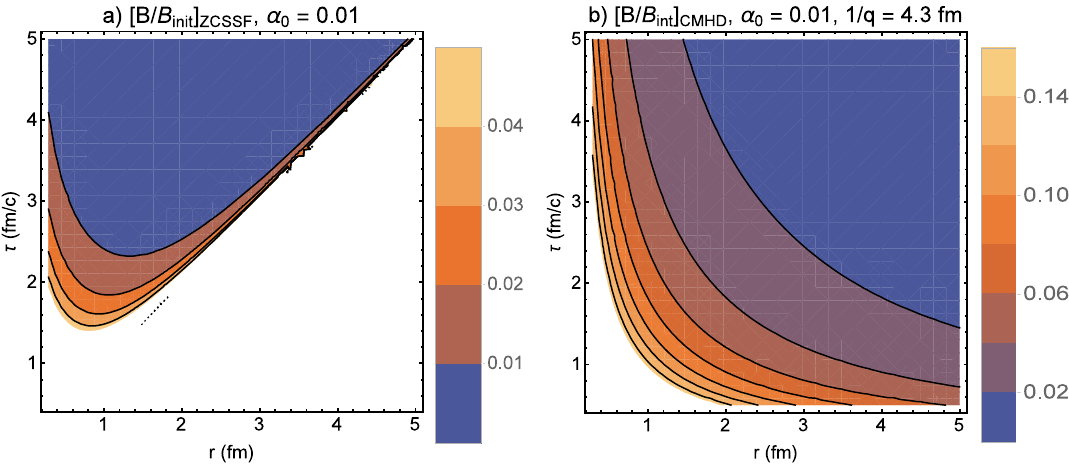
Figure 1 . (color online). (a) The ( τ, r ) dependence of B/B init. for the ZCSSF solution (C.9) is plotted for α 0 = 0 . 01. The magnetic field turns out to be restricted to the domain r The ( τ, r ) dependence of B/B init. for the CMHD solution (C.15) is plotted for α 0 = 0 . 01 and 1 /q = 4 . 3 fm [ 23]. In contrast to the ZCSSF case, there is no restriction on the radial domain of the CMHD